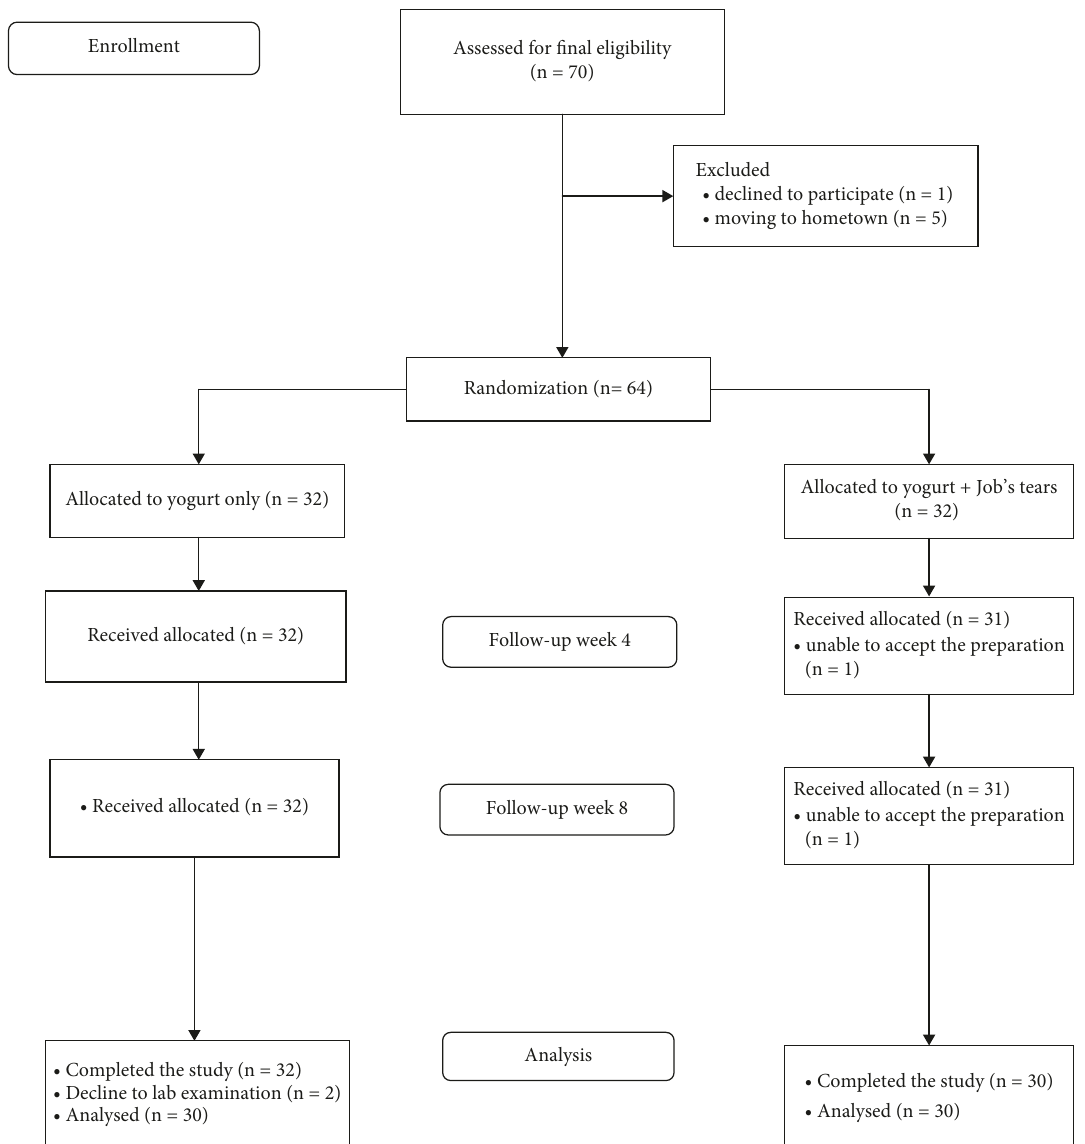
Figure 1: Standard CONSORT